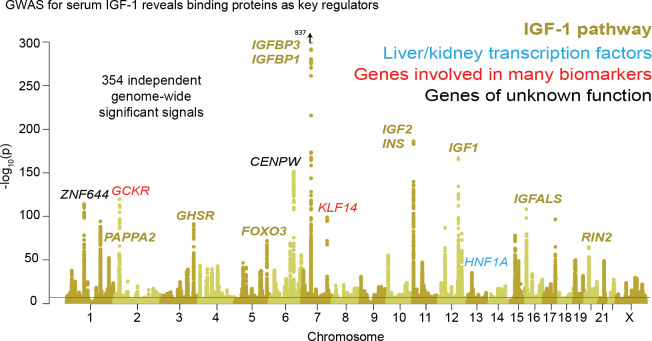
Genetic basis of IGF-1 variation.Manhattan plot showing the locations of major genes associated with IGF-1 levels in the IGF-1 pathway (yellow), transcription factor (blue), pleiotropic gene (red), or unknown function (black) genes sets.